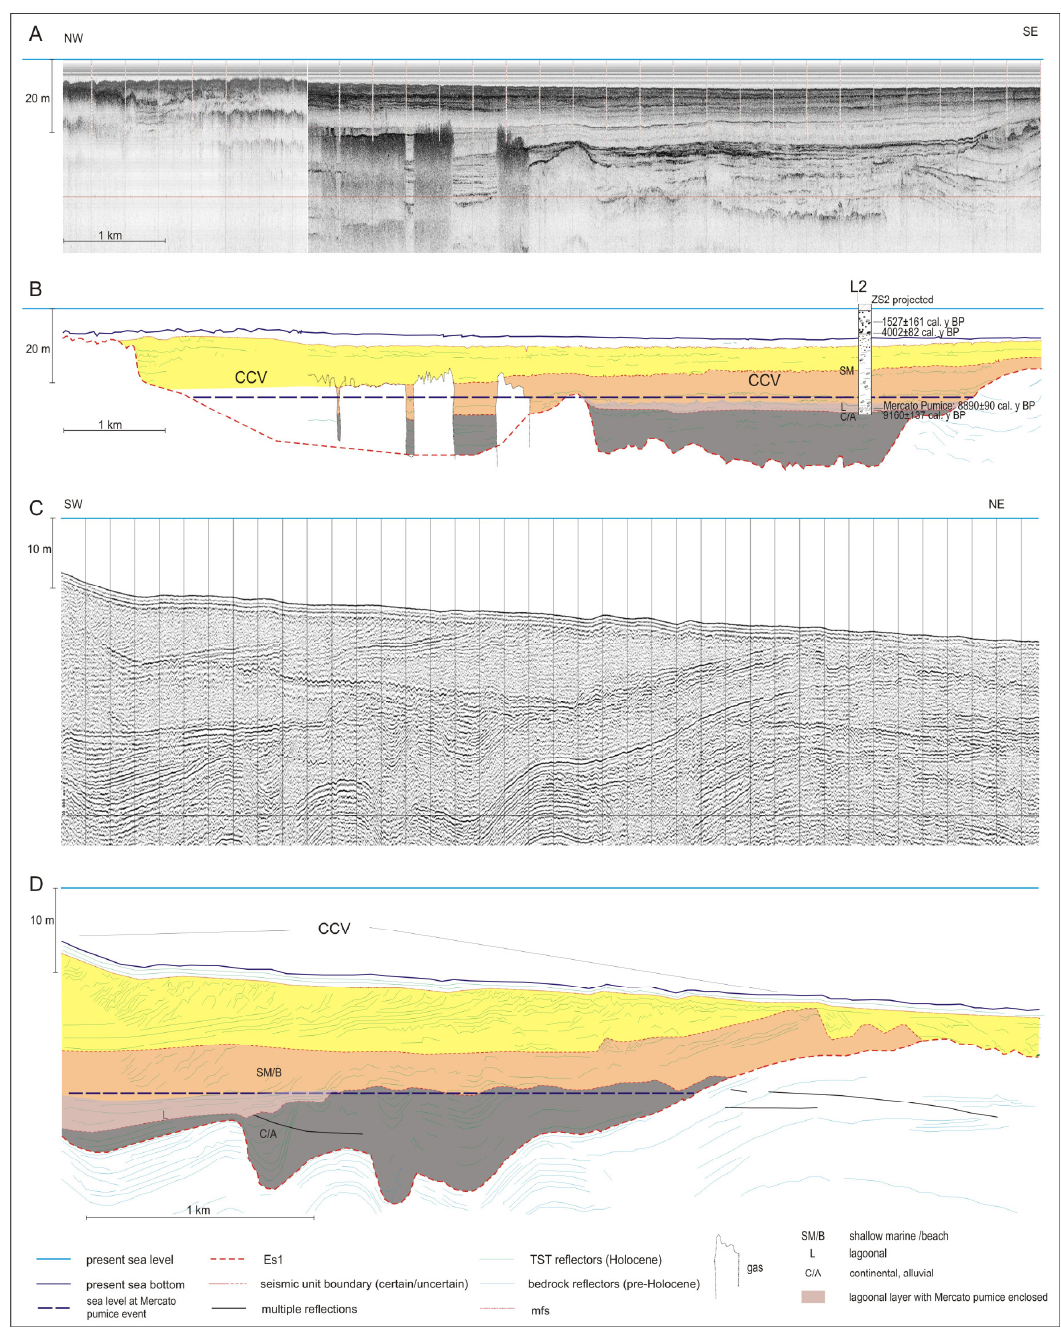
Figure 15. Southeastern sector of the profile T1 ( A ) and its interpretation ( B ), in which the stratigraphic log of ZS2 borehole has been projected. Inland sector of the T8 profile ( C ) and its interpretation ( D ). The lagoonal level containing the Mercato pumice in borehole ZS2 has been correlated both to a series of very high-amplitude reflectors placed roughly at the same depth in the nearby profile T1 at the base of unit E u and to seismic facies 3 reflectors placed roughly at the same depth at the base of unit E u in profile T8.